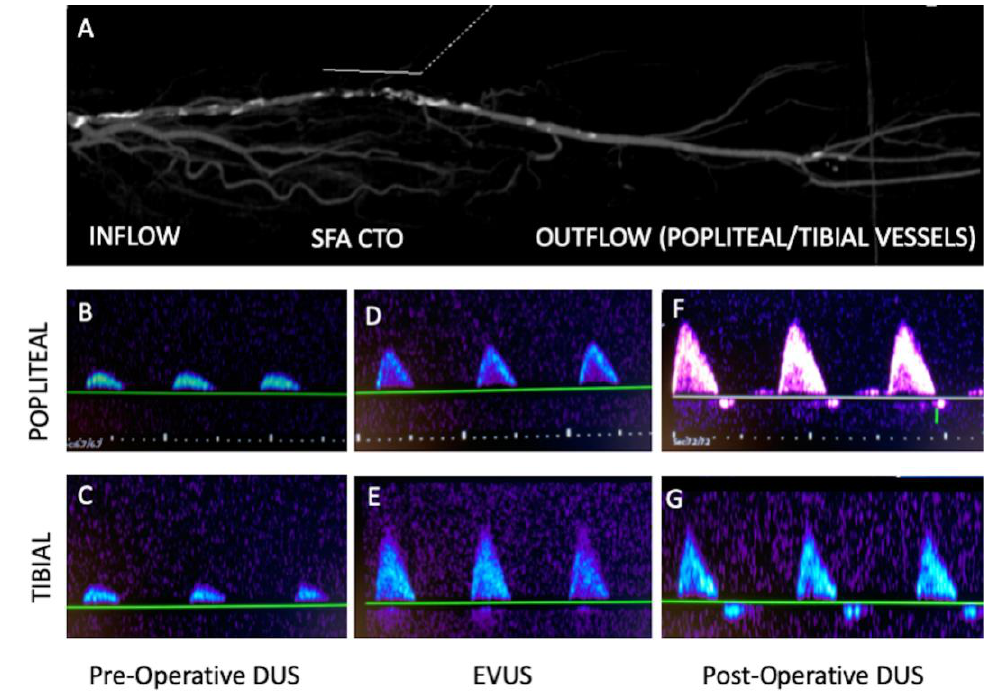
Figure 6. Case 4, right superficial femoral artery occlusion, treated by POBA/DCB. ( A ) CTA showing short SFA CTO with diseased inflow vessel (multiple stenoses with monophasic waveform) and patent outflow vessels/popliteal and tibial; ( B , C ) Preoperative DUS showing very low monophasic waveform at popliteal and tibial vessels. ( D , E ) EVUS shows a better outflow with improved monophasic waveforms. ( F , G ) Postoperative DUS showing a further better outflow with triphasic waveforms.